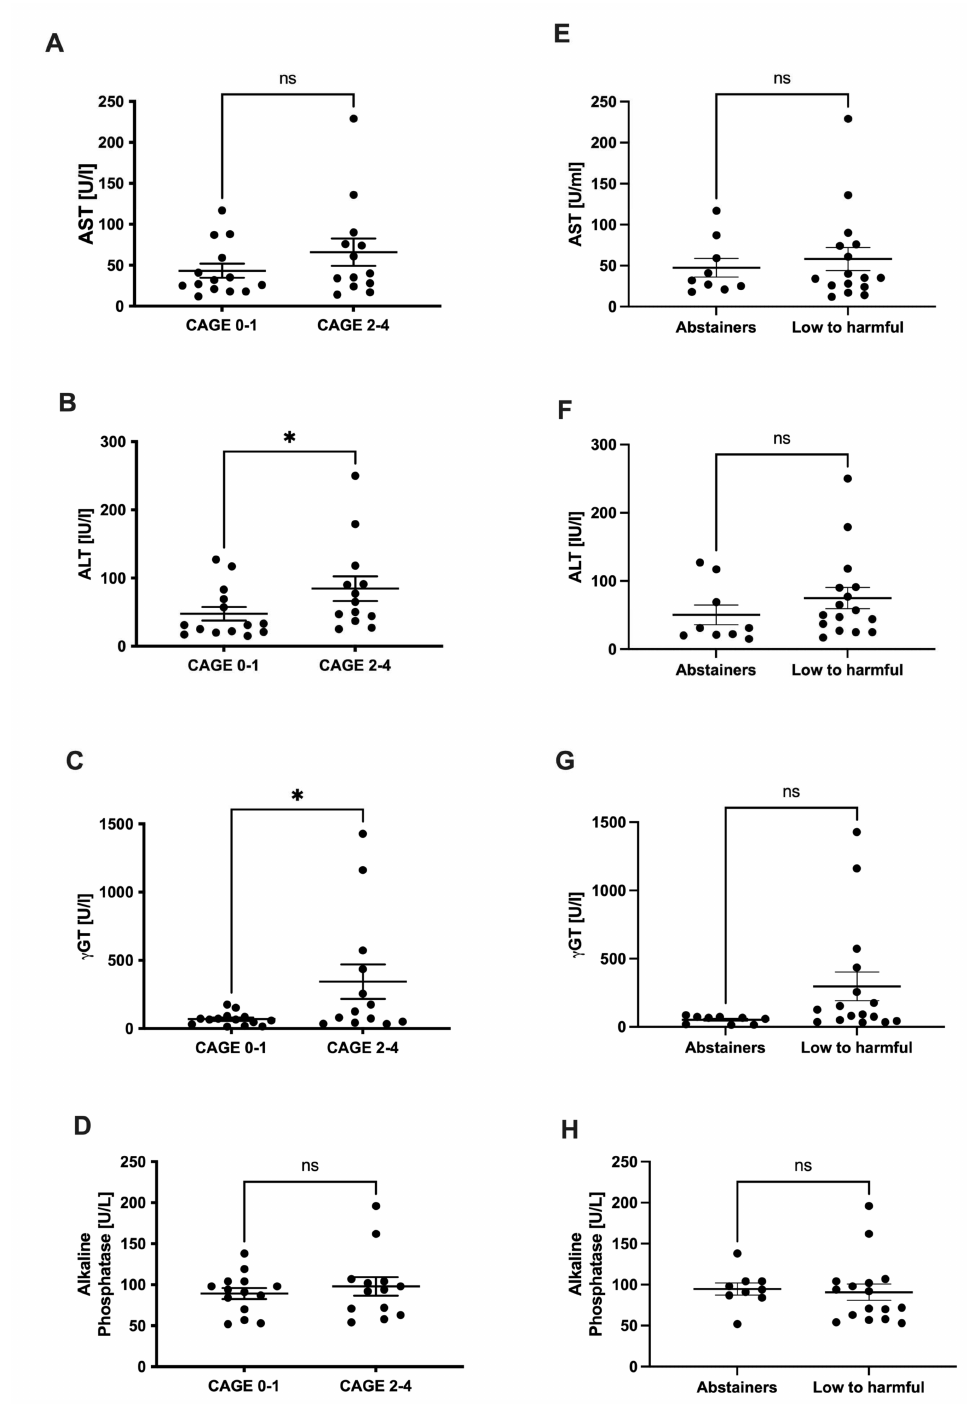
Figure 1. Liver injury parameters. Comparison of parameters of liver injury in serum of NASH pa- tients. Levels of AST ( A , E ), ALT ( B , F ), γ GT ( C , G ), and alkaline phosphatase ( D , H ) were compared in CAGE 0–1 versus CAGE 2–4 (CAGE questionnaire) and abstainers versus low to harmful consumers (AUDIT questionnaire). * p < 0.05. ns stands for not